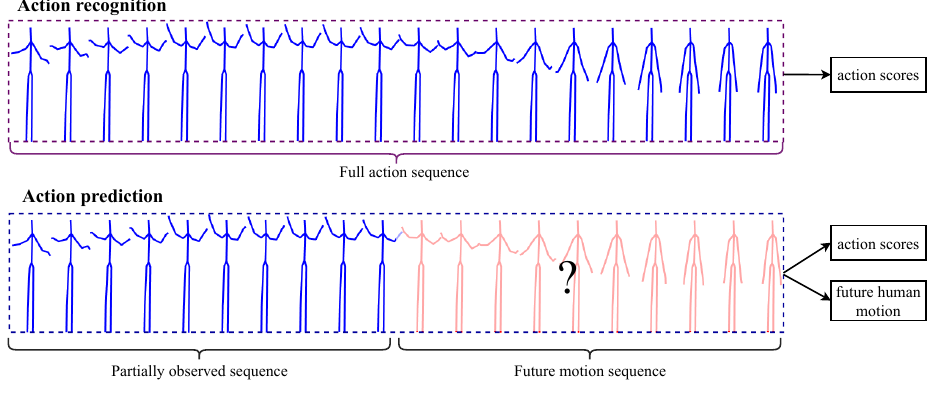
Figure 1. Human activity